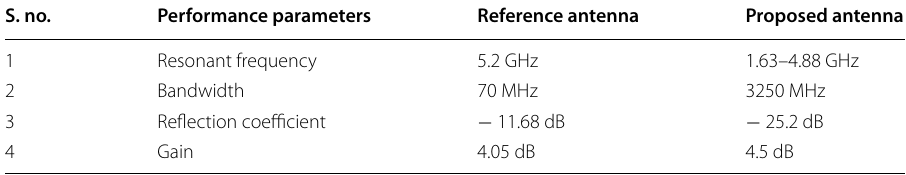
Table 1 Comparison of performance parameters of reference antenna with proposed antenna S. no.